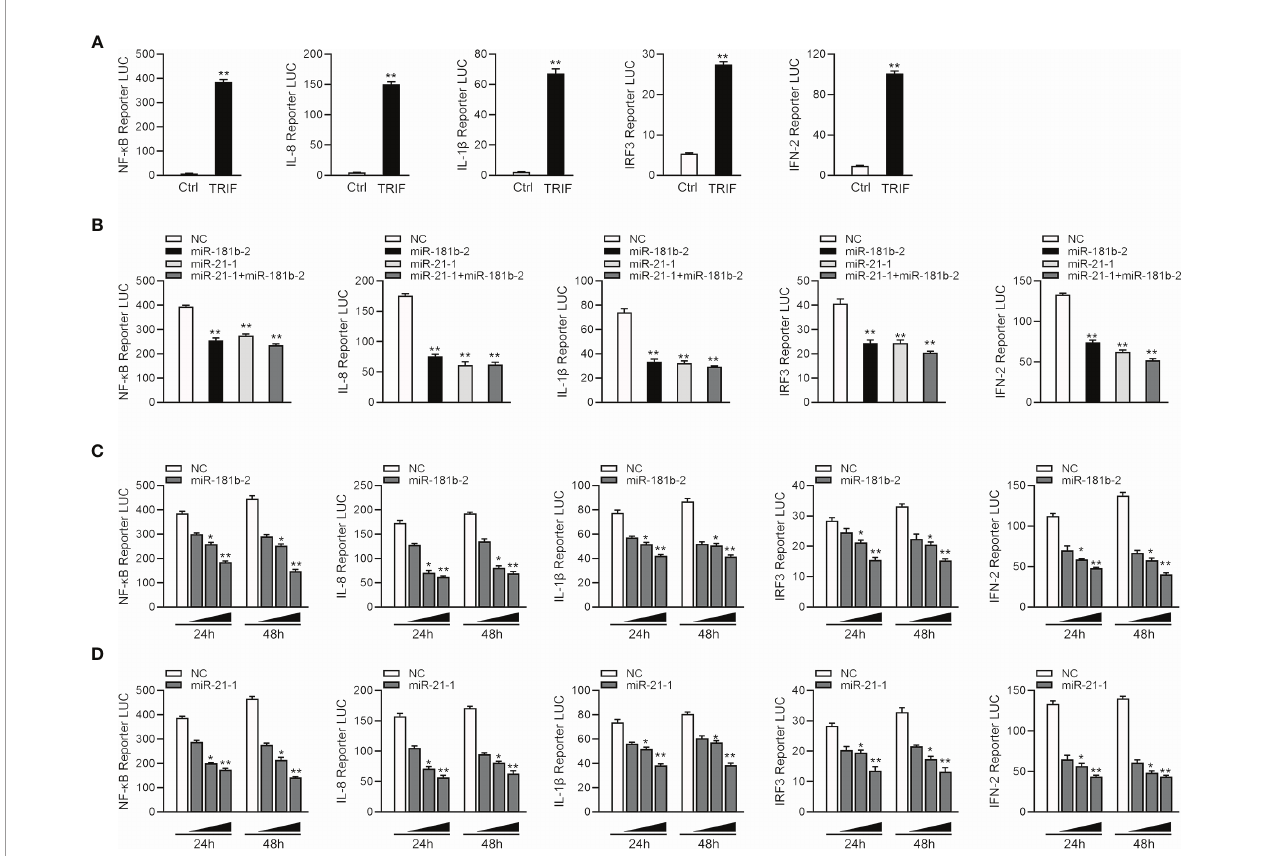
FIGURE 5 | MiR-21-1 or miR-181b-2 regulates NF- k B signaling pathway by regulating TRIF. (A) TRIF expression plasmid and NF- k B, IL-8, IL1 b , IFN-2, IRF3 with PhRL-TK luciferase reporter gene vector were cotransfection into EPC cells, mock is TRIF negative control, 48 h later detection of luciferase activity. (B) We cotransfect miR-21-1 and miR-181b-2 and TRIF expression plasmid with NF- k B, IL-8, IL1 b , IFN-2 and IRF3 reporter gene and PhRL-TK luciferase reporter vector into EPC cells. After 24 h, cells were collected, and the fi re fl y fl uorescence intensity was measured. (C, D) miR-181b-2 (0, 25, 50, and 100 nM) (C) and miR-21-1 (0, 25, 50, and 100 nM) (D) along with NC (100, 75, 50, and 0 nM) and TRIF expression plasmid with NF- k B, IL-8, IL1 b , IFN-2 and IFN-3 reporter gene and PhRL-TK luciferase reporter vector were transfected into EPC cells, and designed concentration-gradient. After 24 or 48 h, cells were collected and the fi re fl y fl uorescence intensity was measured, and normalization was performed according to the fl uorescence activity of the Renilla . All data are presented as the means ± SE from three independent triplicate experiments. ** p < 0.01, * p < 0.05 versus the